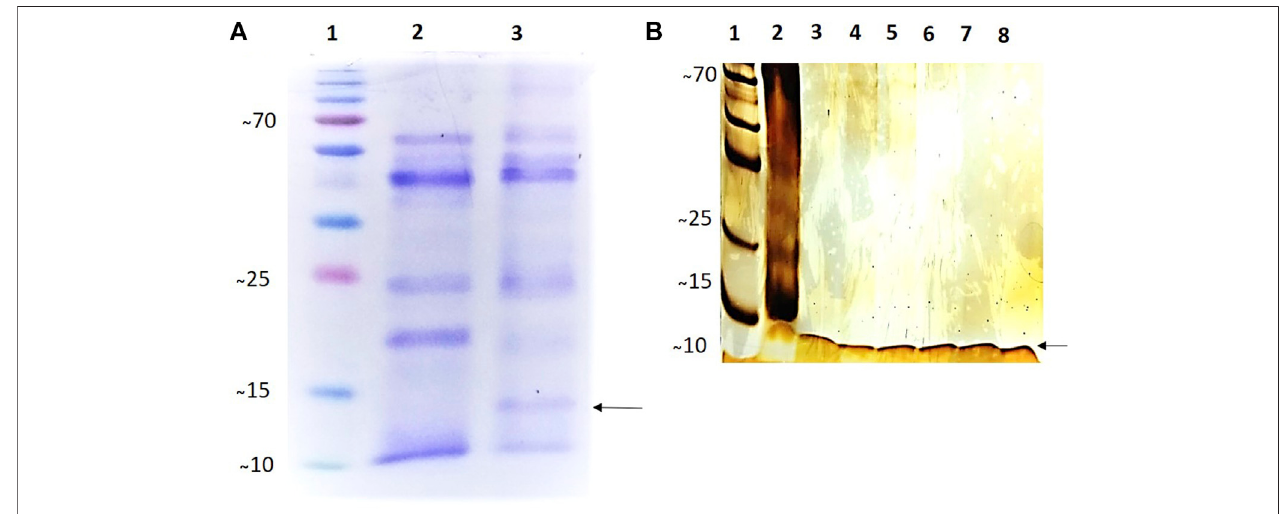
FIGURE 3 | Analysis of the expression and puri fi cation of rCystatin-B with SDS-PAGE (120 h of induction). (A) . Gel stained with 0.25% Coomassie blue; (Lane 1). PMM - Molecular Mass Standard - kDa (Invitrogen). (Lane 2). Lyophilized fraction (crude extract) of Pichia pastoris cell culture without cloned plasmid (negative control) subjected to the inductionandexpressionprocess;(Lane3).Transformedandlyophilizedfractionofthecultureof Pichiapastoris cellssubjectedtotheinductionandexpressionprocess(inclusion of cloned plasmid: pPIC_Cystatin-B). (B) . Gel stained with Silver Nitrate (20%). (Lane 1). PMM - Molecular Mass Standard - kDa (Invitrogen). (Lane 2). Transformed and lyophilized fraction of the culture of Pichia pastoris cells subjected to the induction and expression process (inclusion of cloned plasmid: pPIC_Cystatin-B). (Lanes 3 – 8). Puri fi ed rCystatin-B protein (indicated by the arrow). The recombinant protein was puri fi ed using Ni Sepharose High-Performance Nickel based resin.